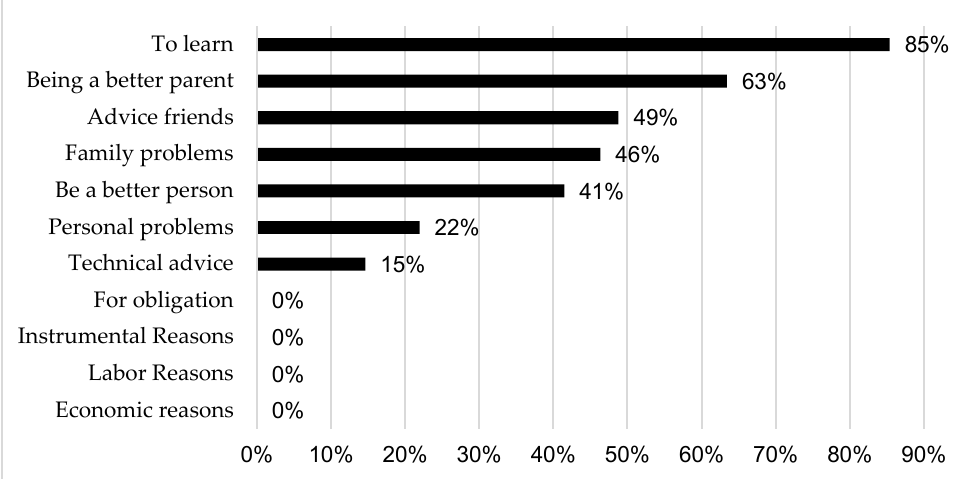
Figure 4. Parents’ motivations to participate in the programme ( N = 14).